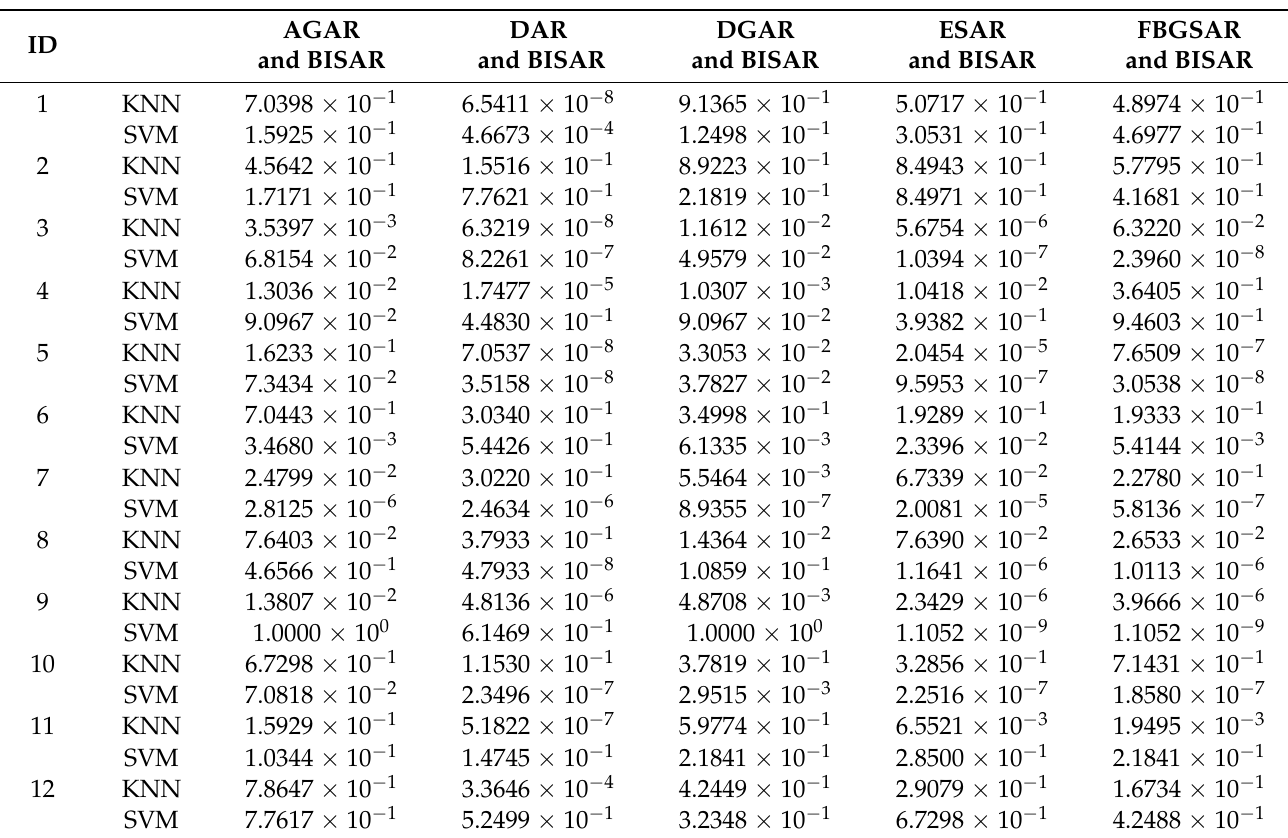
Table 16. p -values for comparing classification accuracies (feature